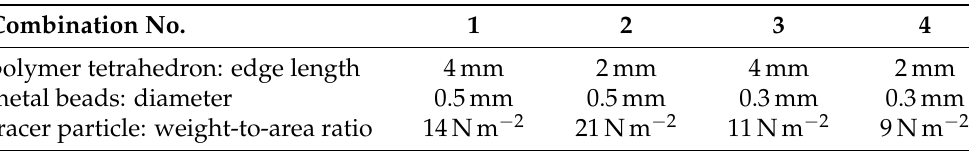
Table 2. Characteristics of the tracer particles used for the X-PTV measurement (No. 1) and further feasible combinations of the edge length of the polymer tetrahedron and the diameter of the metal beads, as well as the resulting weight-to-area ratio of one tracer